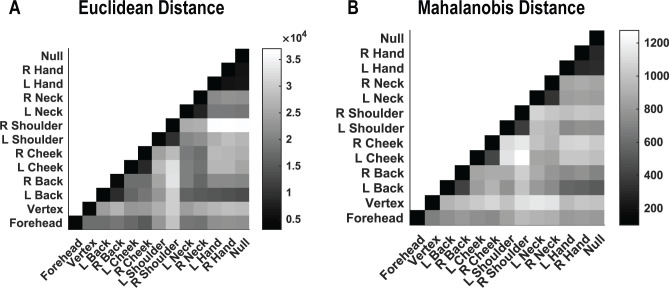
Relationships of population responses to touch are conserved across distance metrics.(A) Population similarity in encoding structure (for correlation data presented in Figure 2B) between test conditions when evaluated by Euclidean separation. Colors represent the distance, as in the scale. (B) Population similarity in encoding structure (for the same data as in A) between test conditions when evaluated by Mahalanobis separation. Colors represent the distance, as in the scale. L: Left; R: right.